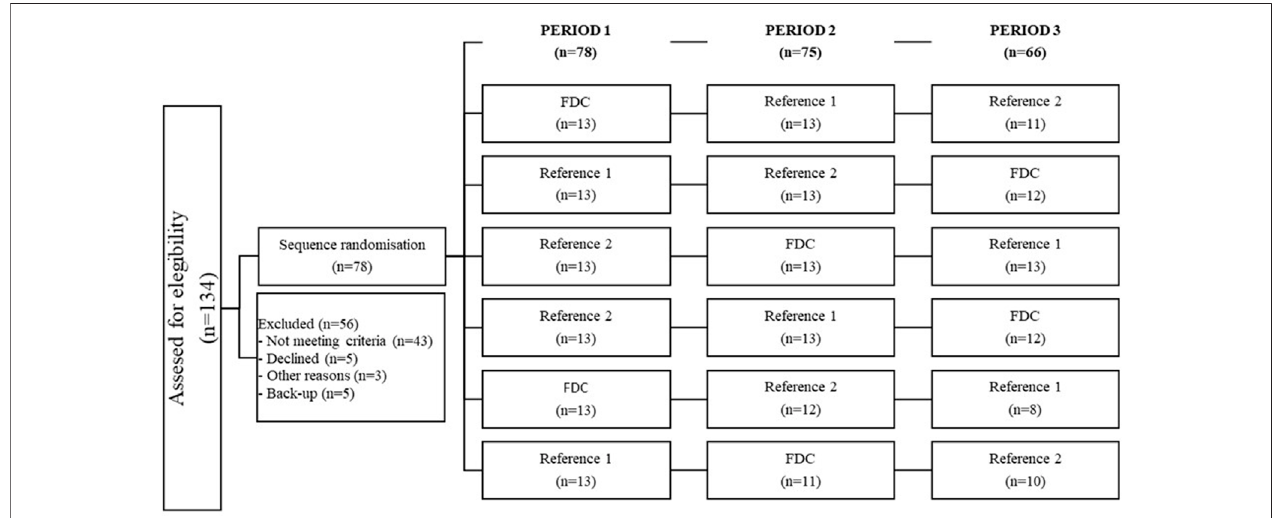
FIGURE 1 | Subject ’ s